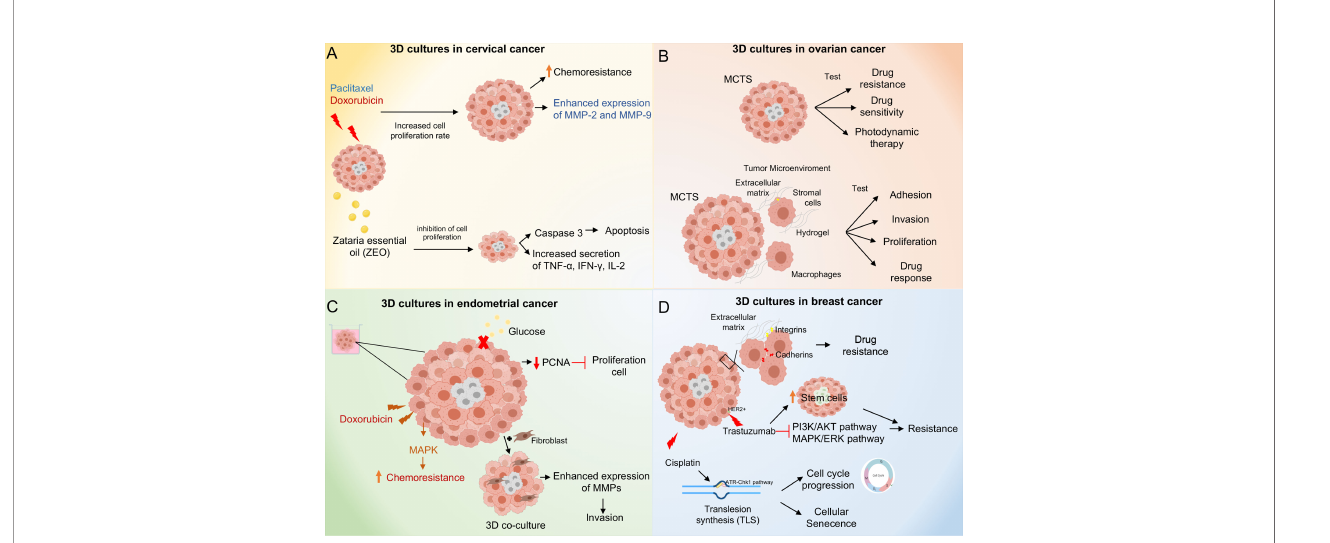
FIGURE 3 | Molecular mechanisms activated in 3D culture systems. (A) 3D cultures of cervical cancer cells result in paclitaxel and doxorubicin chemoresistance through increased proliferation rate and overexpression of MMP-2 and 9. Zataria essential oil treatment inhibits cell proliferation in 3D cultures and induces apoptosis through activation of caspase 3. (B) 3D culture systems in ovarian cancer. The Multicellular Tumor Spheroids (MCTS) allow testing of drug and photodynamic therapies. The co-culture of MCTS with stromal cells and macrophages in combination with hydrogels as scaffold, allow to mimic the tumor microenvironment providing a model to test adhesion, invasion, proliferation processes as well as drug response. (C) 3D cultures systems in endometrial cancer. Doxorubicin treatment induces chemoresistance through activation of the MAPK pathway. Moreover, 3D cultures of endometrial cancer co-cultured with fi broblasts promote invasion through overexpression of MMPs. (D) 3D cultures systems in breast cancer. Spheroids of breast cancer cells exhibit cell-cell and extracellular cell-matrix interactions promoting drug resistance. Cisplatin treatment promotes cell cycle progression and cellular senescence through up-regulation of trans-lesion DNA polymerase (TLS) expression and activation of the ATR-Chk1 pathway. Trastuzumab treatment induces resistance in 3D cultures through inhibition of PI3K/AKT and ERK/MAPK pathways, in addition to an increase in stem cells